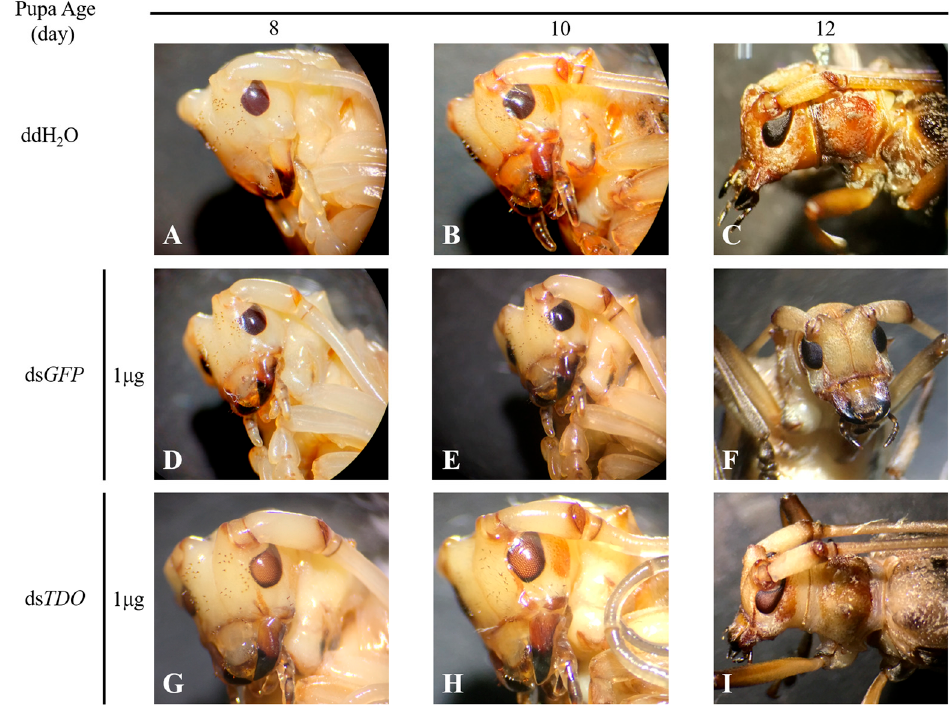
Figure 3. Monochamus alternatus phenotype after injection with dsRNAs. ( A – C ) Control pupae injected with 1 µ L ddH 2 O. ( D – F ) Treatment pupae injected with 1 µ g ds GFP . ( G – I ) Treatment pupae injected with 1 µ g ds TDO . From left to right: 8, 10, and 12 days after injection.